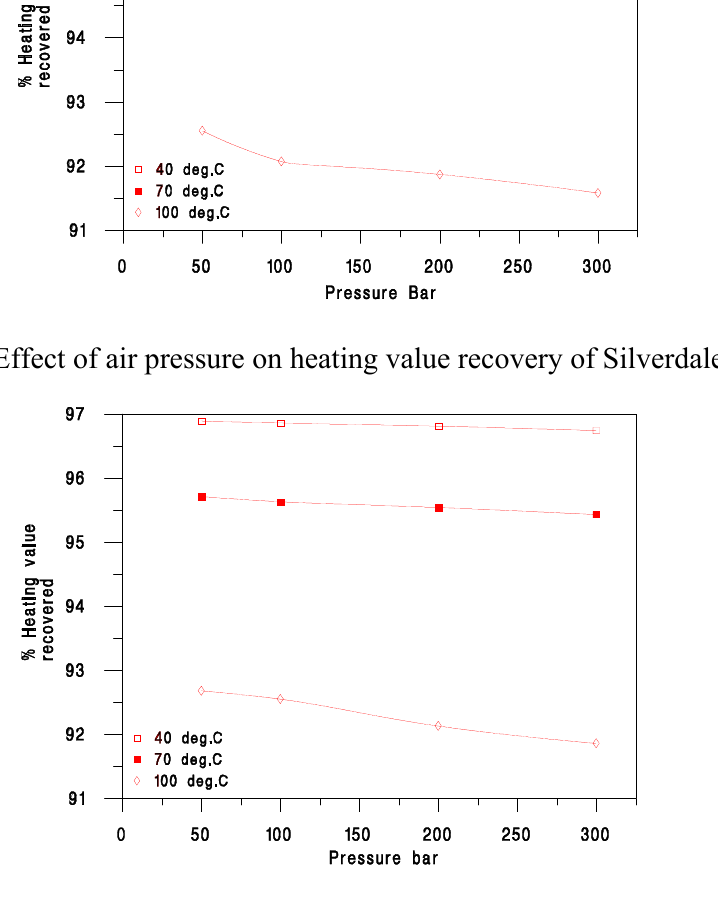
Figure 10. Effect of air pressure on heating value recovery of Harworth